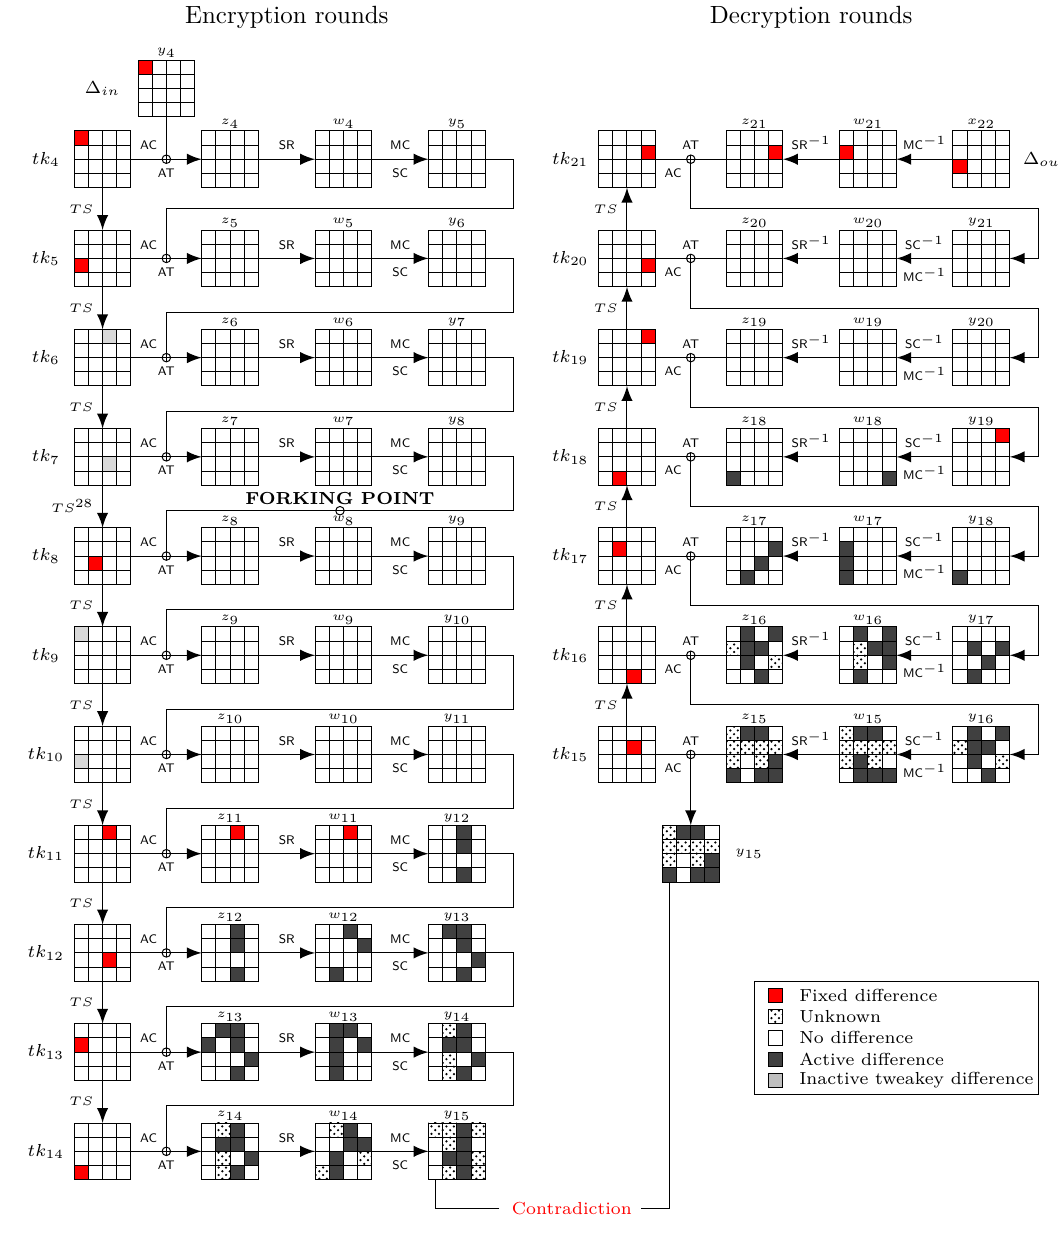
Figure 8: Impossible differential characteristic for 18-round ForkSkinny-128-256, using the second branch (4 rounds before forking point, 14 rounds after forking